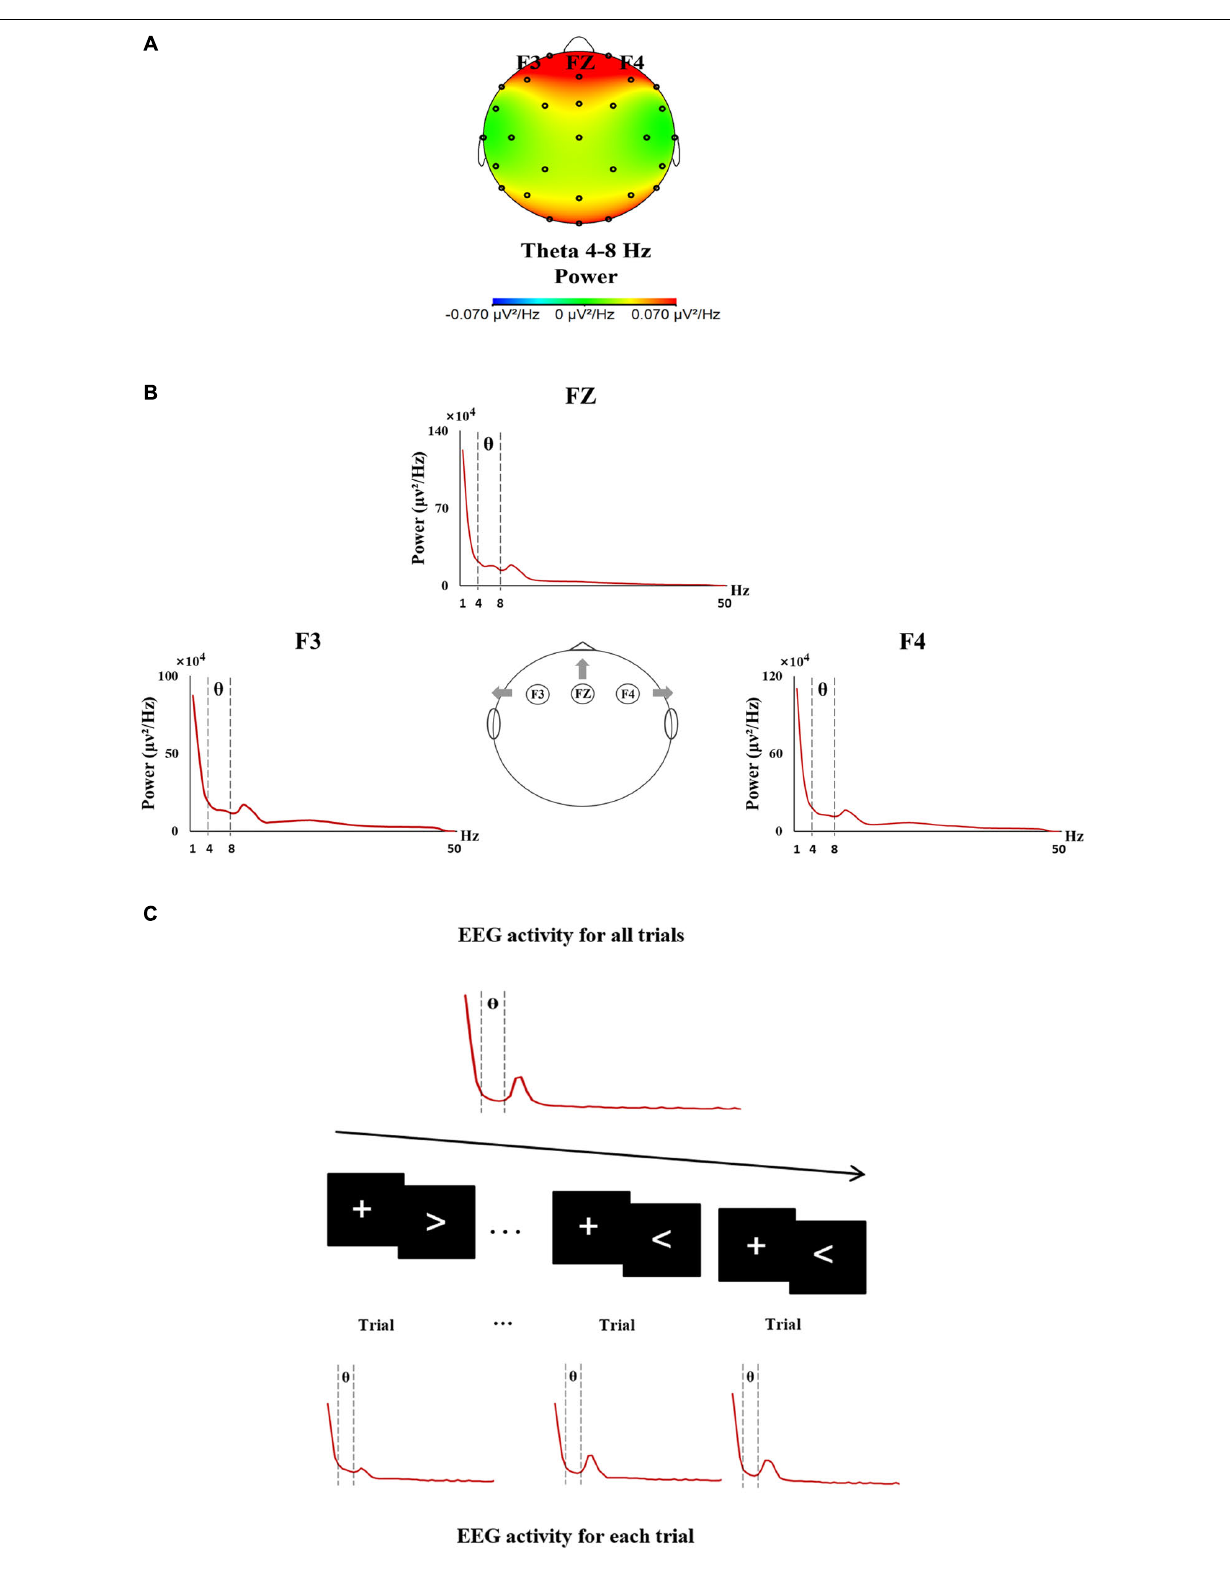
Frontiers in Psychology |